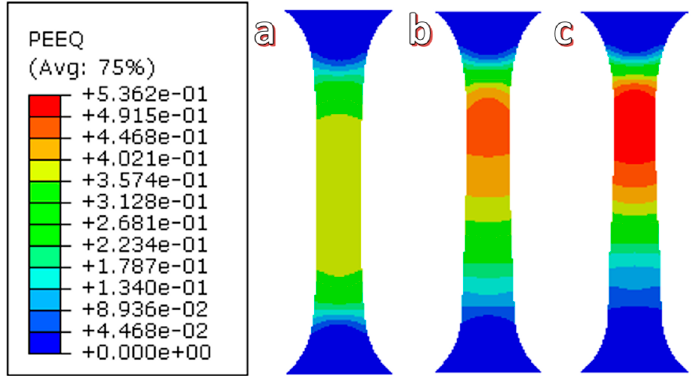
Figure 10. The distribution of the simulated equivalent strain of the uniaxial tensile of Zr35 at different ultrasonic vibration amplitudes: ( a ) 0 μ m; ( b ) 12 μ m; and ( c ) 24 μ m.